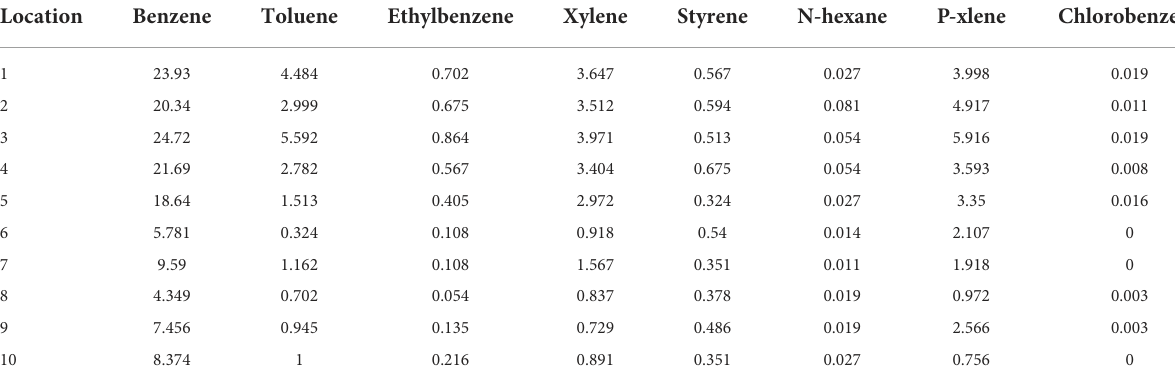
TABLE 10 The respiratory risk evaluations (CDI) of VOCs in study sites. Location